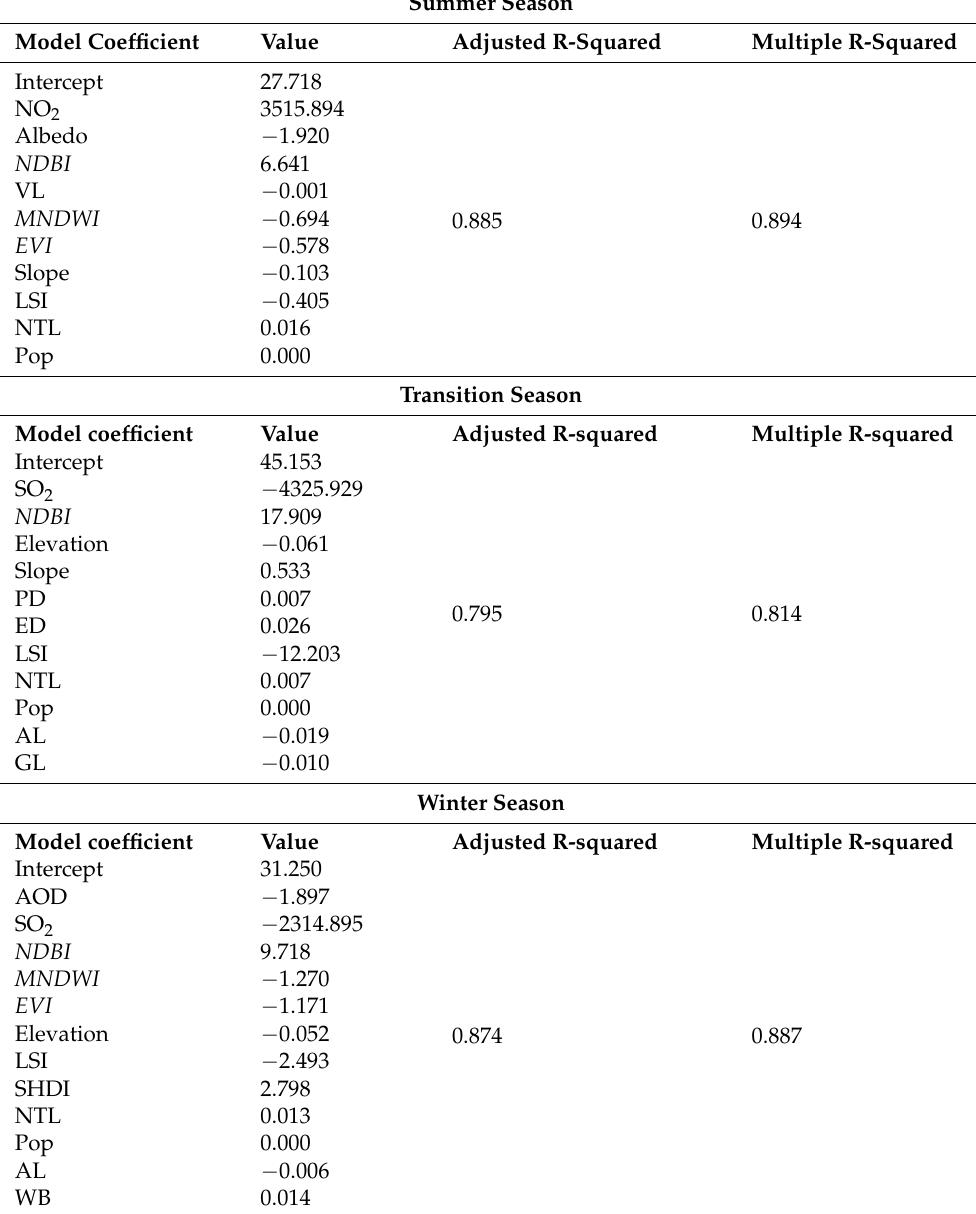
Table 8. Results from optimum regression model of integration of all influencing factors for different